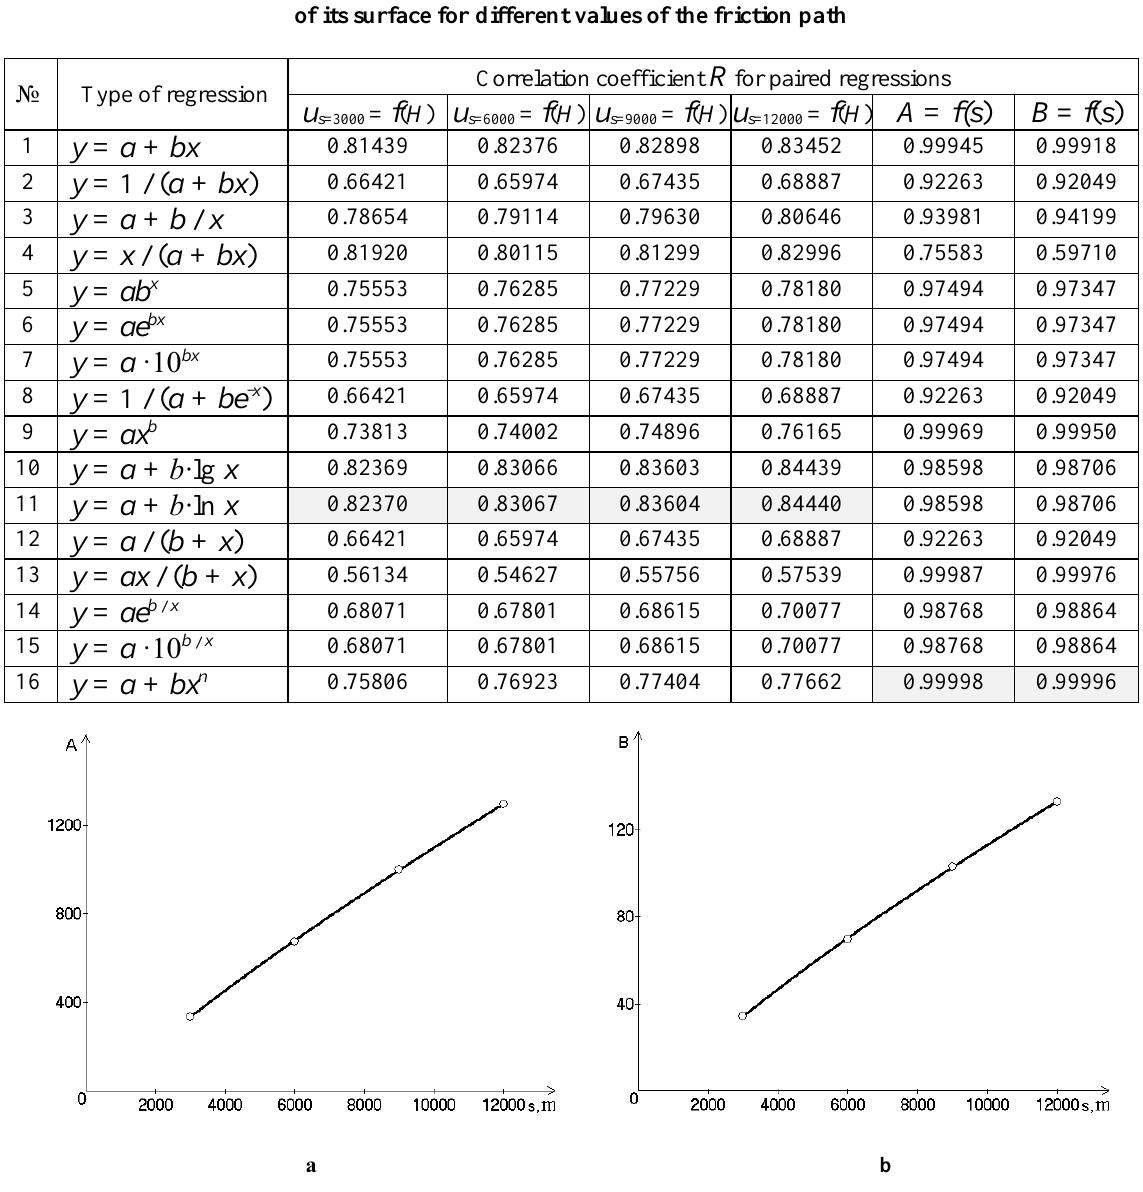
Fig. 2. Dependences of regression coefficients on the friction path а – A = f ( s ); b – B = f ( s ); actual○, theoretical